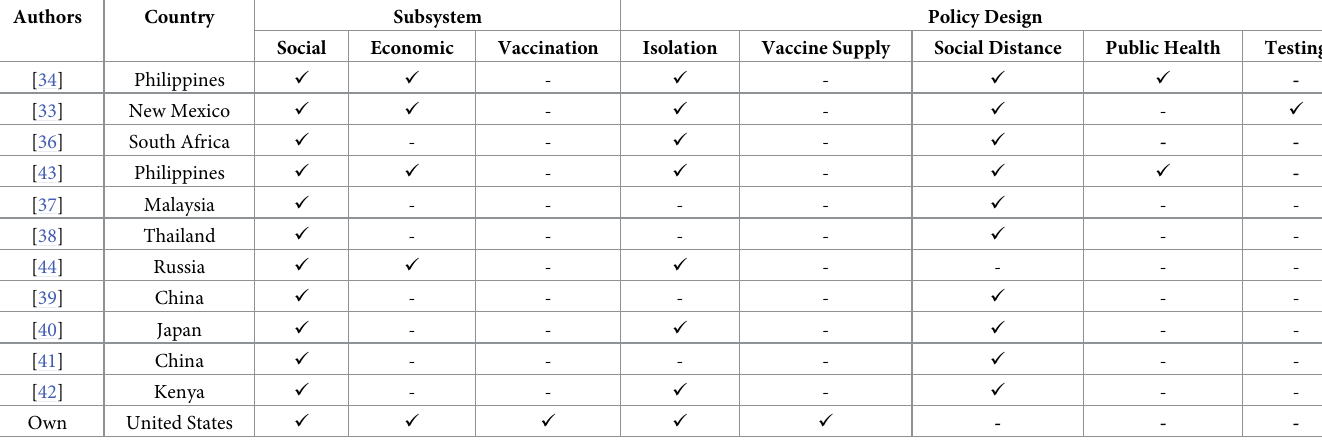
Table 1. Related research to COVID-19